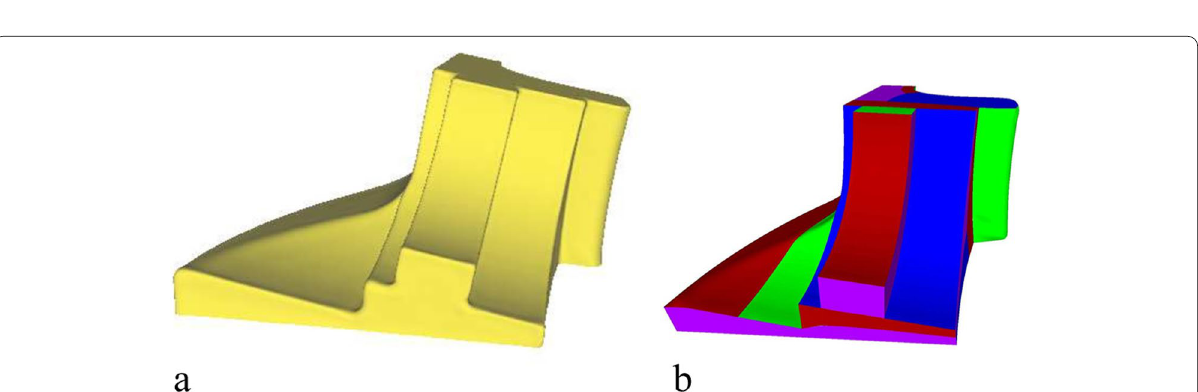
Fig. 13 Fitted spline surface of Fandisk model. a Fitted spline surface; b Fitted